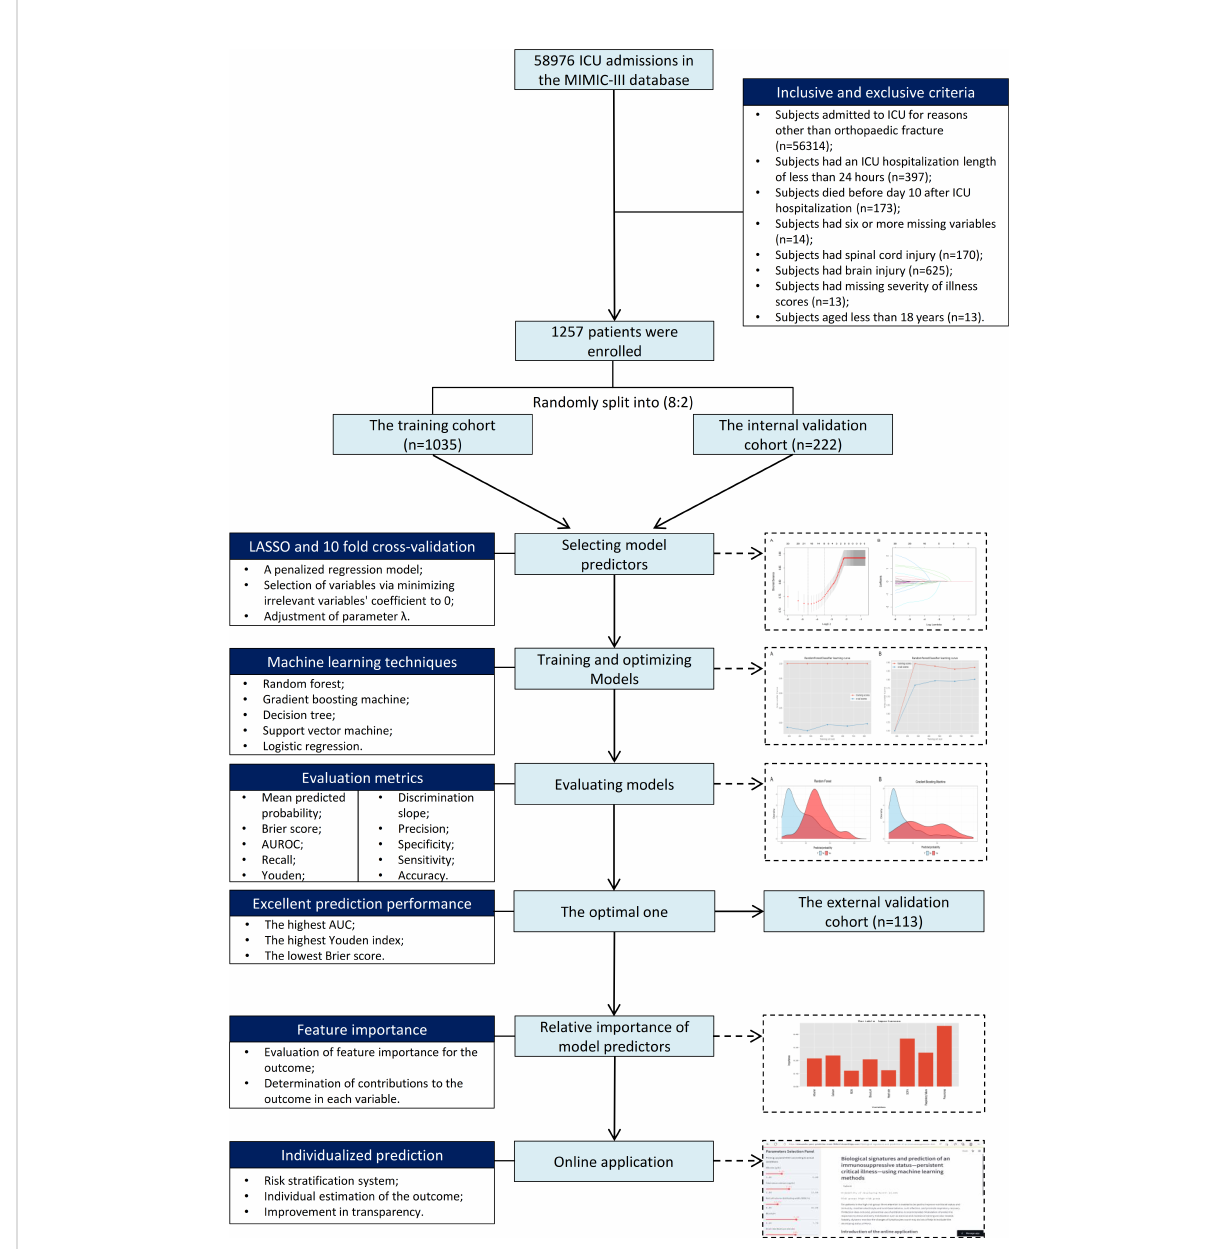
FIGURE 1 Flow diagram outlining patient enrollment, classi fi cation, and the study